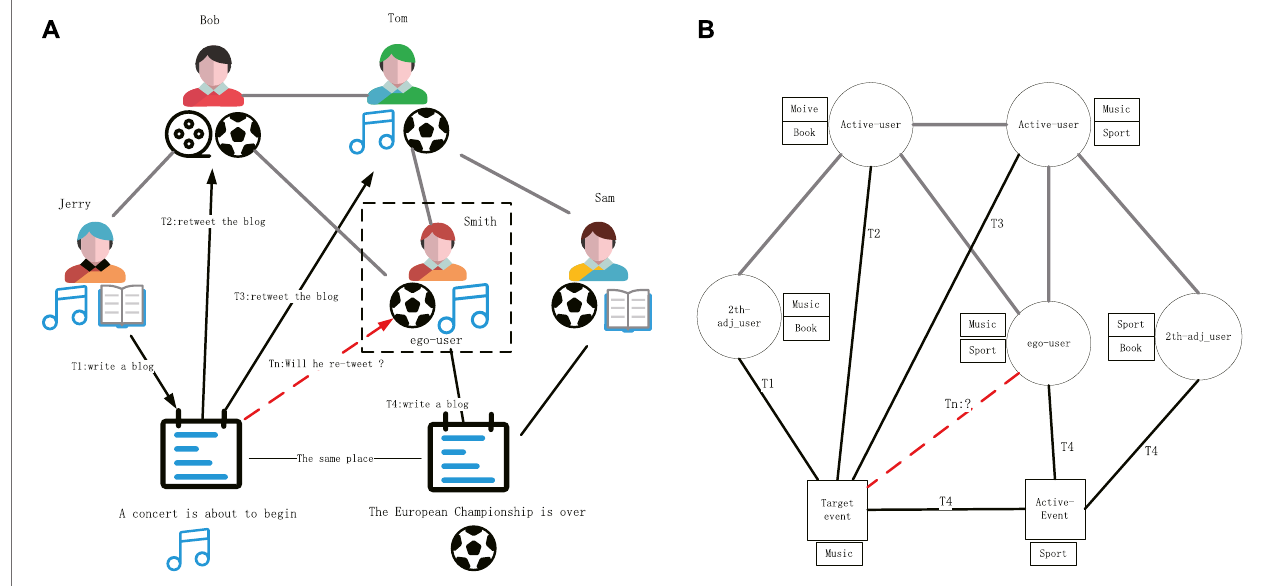
FIGURE 1 | Problem illustration of mining user – event in fl uence in heterogeneous networks and predicting user behaviors. Figure 1A shows an instantiated prediction case, and the goal is to predict whether Smith (ego-user) will forward the concert blog (whether the red line will occur in the future). Figure 1B is obtained by abstracting Figure1A ,given1)therelationshipbetweentheuserandtheeventwithintheobservabletime(theconnectioninbincludesthreerelationships:u-u,u-e,and e-e); 2) the embedding representation of the attributes of different nodes in the observable time (the rectangle next to the node in b); 3) the activation state of neighbor nodes (active or inactive); and 4) the embedding representation of each node in the network, then we predicted whether ego-user will participate in the target event.